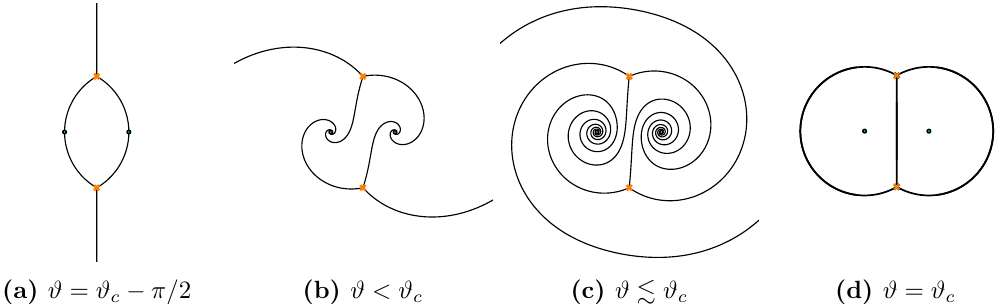
Figure 5. A 1 spectral networks on the three-punctured sphere. As the phase reaches # c , all S -walls collapse into three double-walls. This is the BPS graph of the T 2 (trinion) theory.